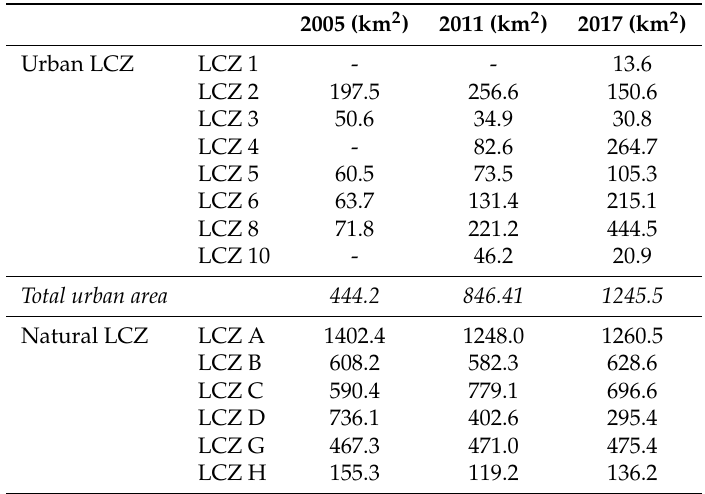
Table 3. Total surface area (km 2 ) of each LCZ for the different